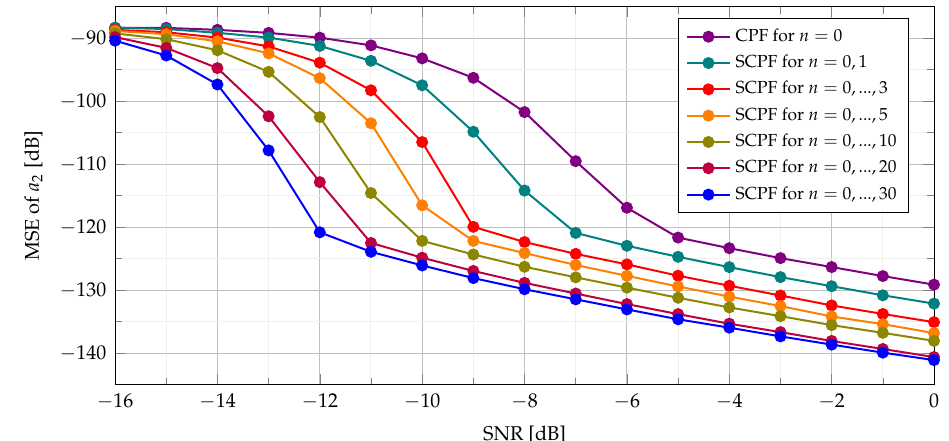
Figure 12. Influence of the number of SCPF slices on MSE.